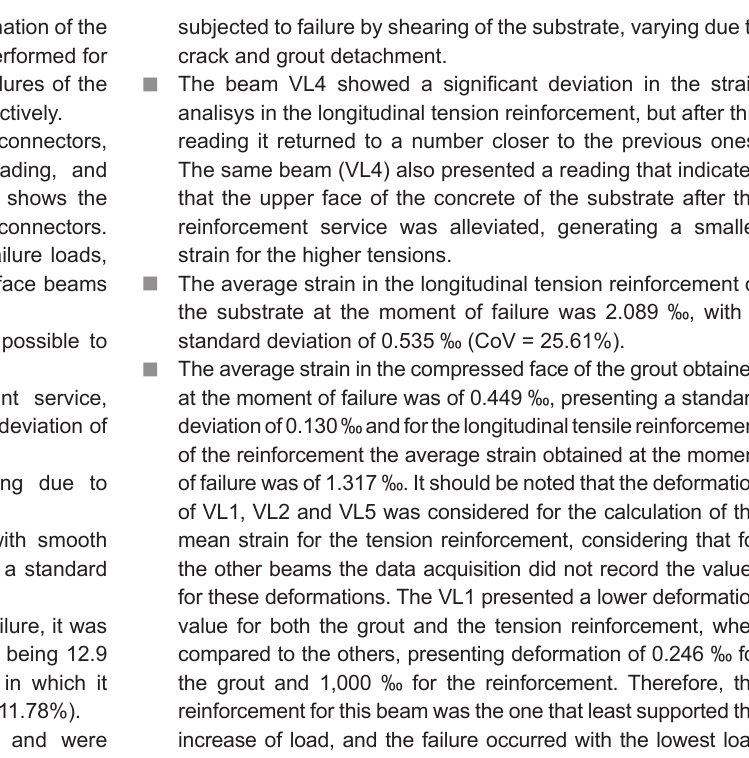
Table 5 Results of beams with smooth interface without connectors